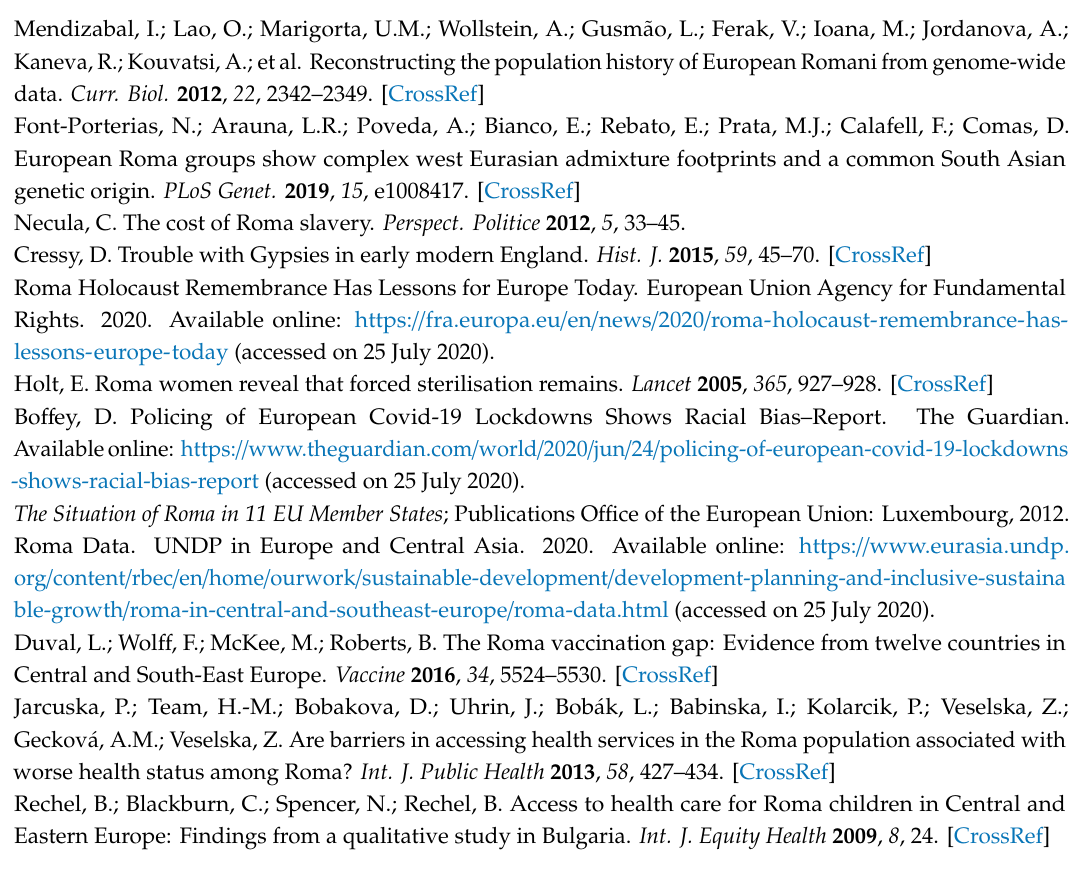
Table S1: Roma over Europe, S1: Search terms, Table S2: Quality